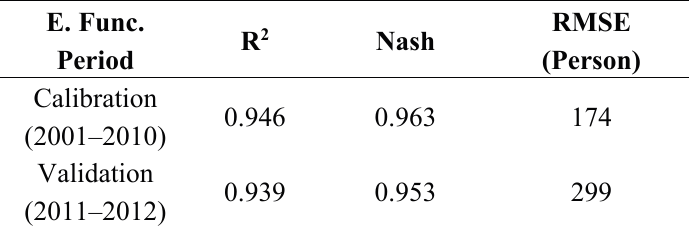
Table 2. Evaluation function value of each